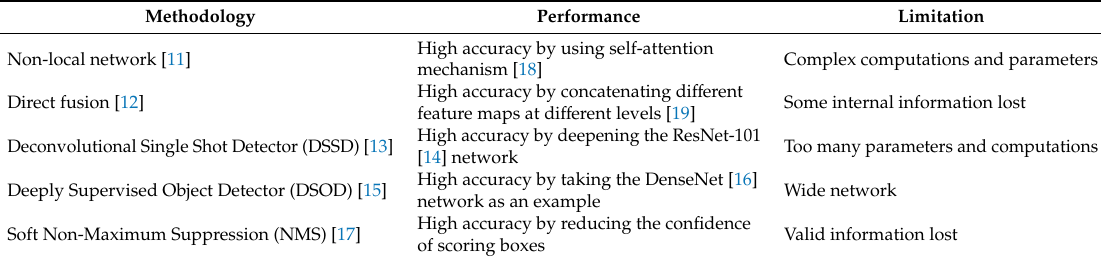
Table 1. Performances and limitations of di ff erent